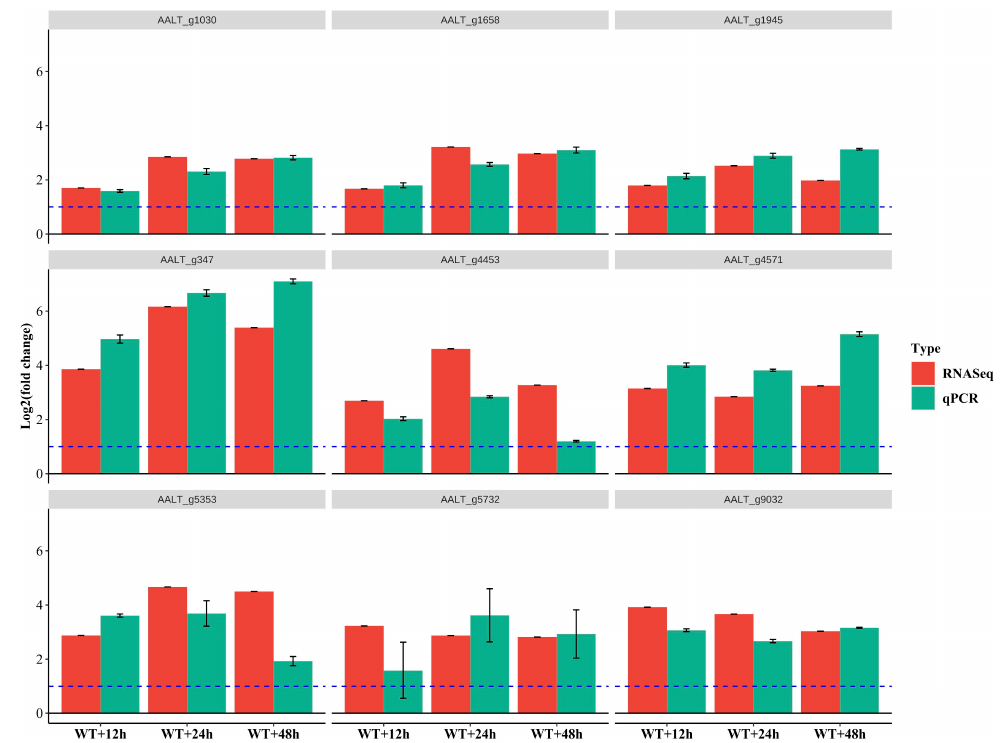
Figure 8. The expression of the gene related to the peroxisome pathway in Alternaria alternata during infection stages was investigated. For this purpose, mycelia of A. alternata Z7 were inoculated on tangerine leaves and harvested at 12-, 24-, and 48 h post-inoculation. The blue dotted line in the figure represents Log2(FC) =